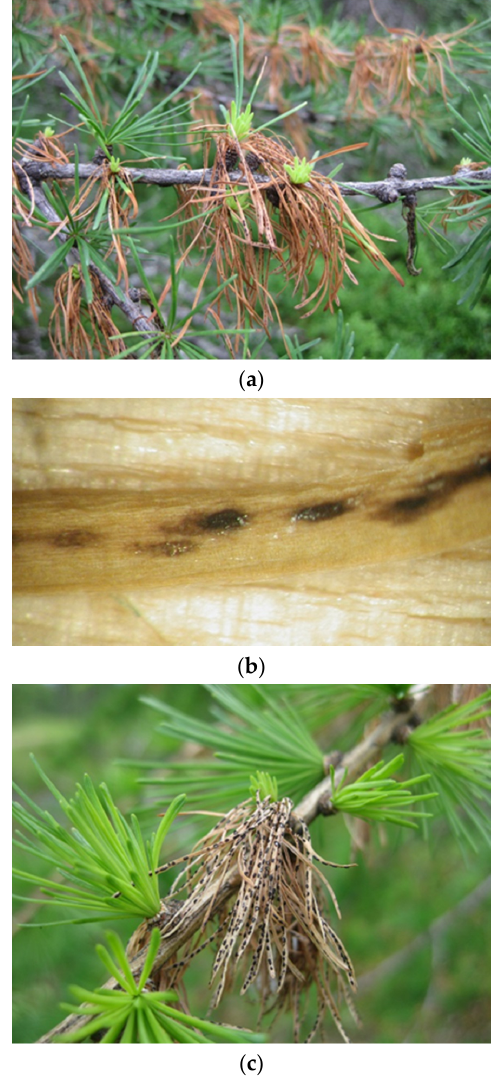
Figure 2. Symptoms of Hypodermella laricis in the Kivalo Research Forest. ( a ) Newly infected reddish-brown needles are already drooping with visibly developing fruiting bodies; the spur shoot is recovering with a new set of needles; the previous year’s infection has resulted in needles that direct downwards in one spur shoot and the death of two spur shoots next to it; Siberian larch, 12 July 2011; ( b ) Conidiomata of Leptothyrella laricis , on a Siberian larch needle primarily infected by Hypodermella laricis , 18 June 2011; ( c ) Open hysterothecia of Hypodermella laricis on European larch, one year after infection, 22 June 2014.